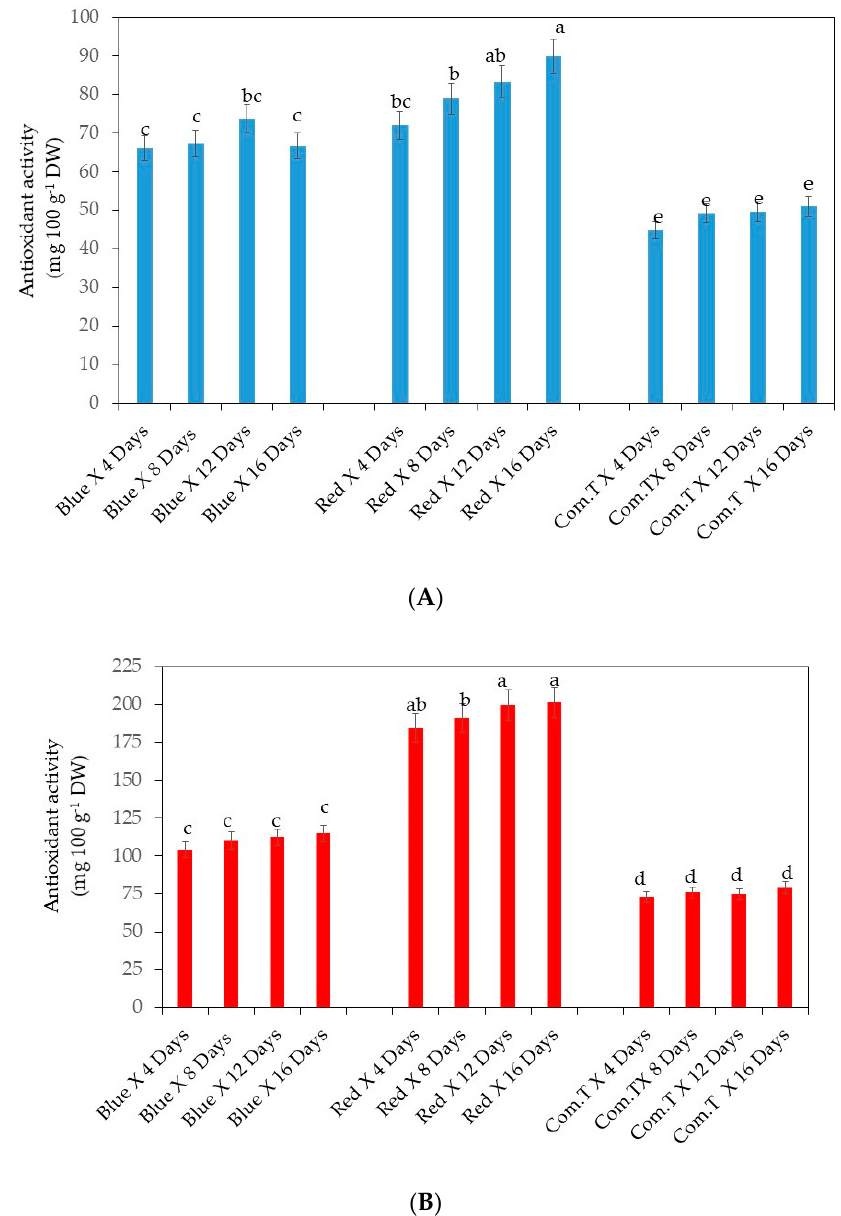
Figure 11. ( A ) Antioxidant metabolite contents in avocado cultivar Fuerte treated postharvest with LED lights. ( B ) Antioxidant metabolite contents in avocado cultivar Hass treated postharvest with LED lights. Mean ± standard deviation values for each bar were calculated based on five fruits. Number of replicates per treatment n = 5. Mean values of bars marked by di ff erent letters were significantly di ff erent at p < 0.05, according to Fisher’s protected LSD test. Blue, blue LED light; Red, red LED light; Com.T, commercial treatment.